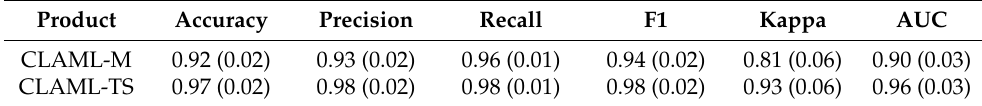
Table 7. Mean values and standard deviation of metrics.